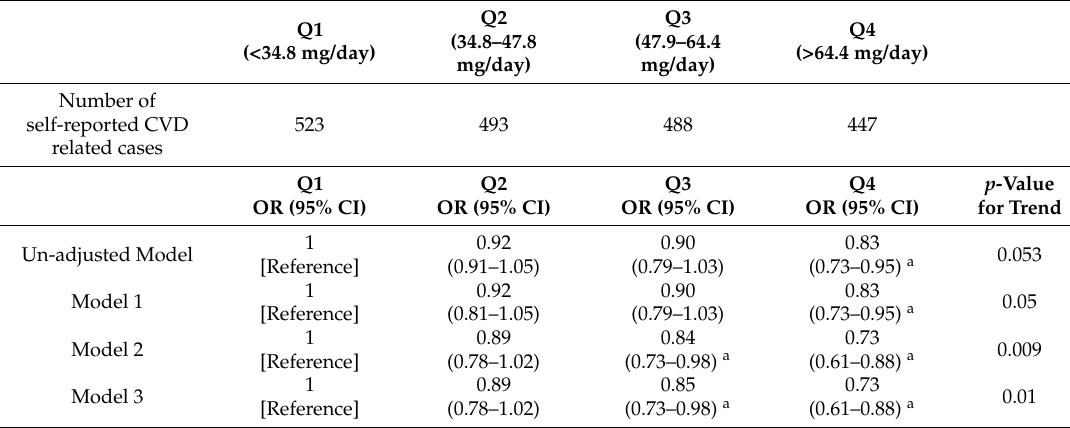
Table 4. Odds of self-reported CVD-related complications by quartile of vegetable nitrate intake in